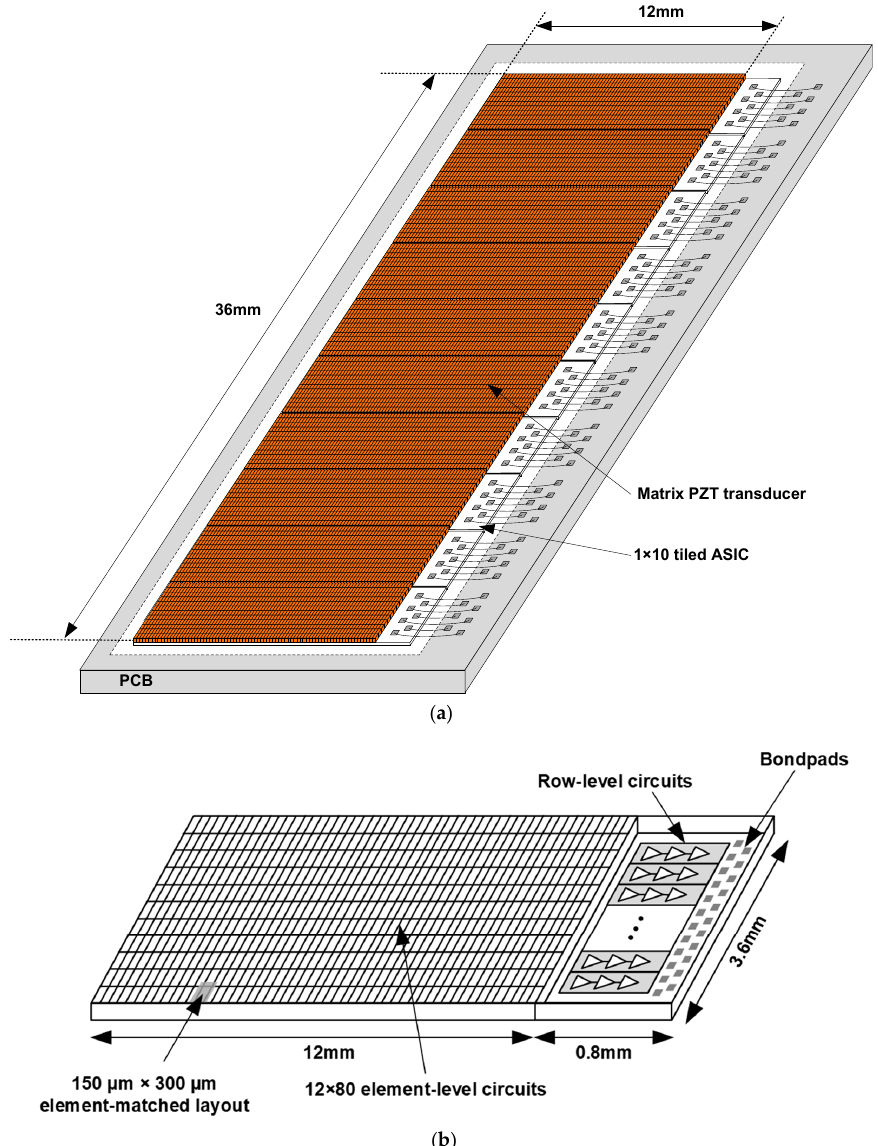
Figure 1. ( a ) Overview of the proposed matrix transducer on tiled application-specific integrated circuits (ASICs). ( b ) Overview of a single tile consisting of 12 × 80 transducer elements on top of an ASIC with 12 × 80 element-level switches and row-level circuits.